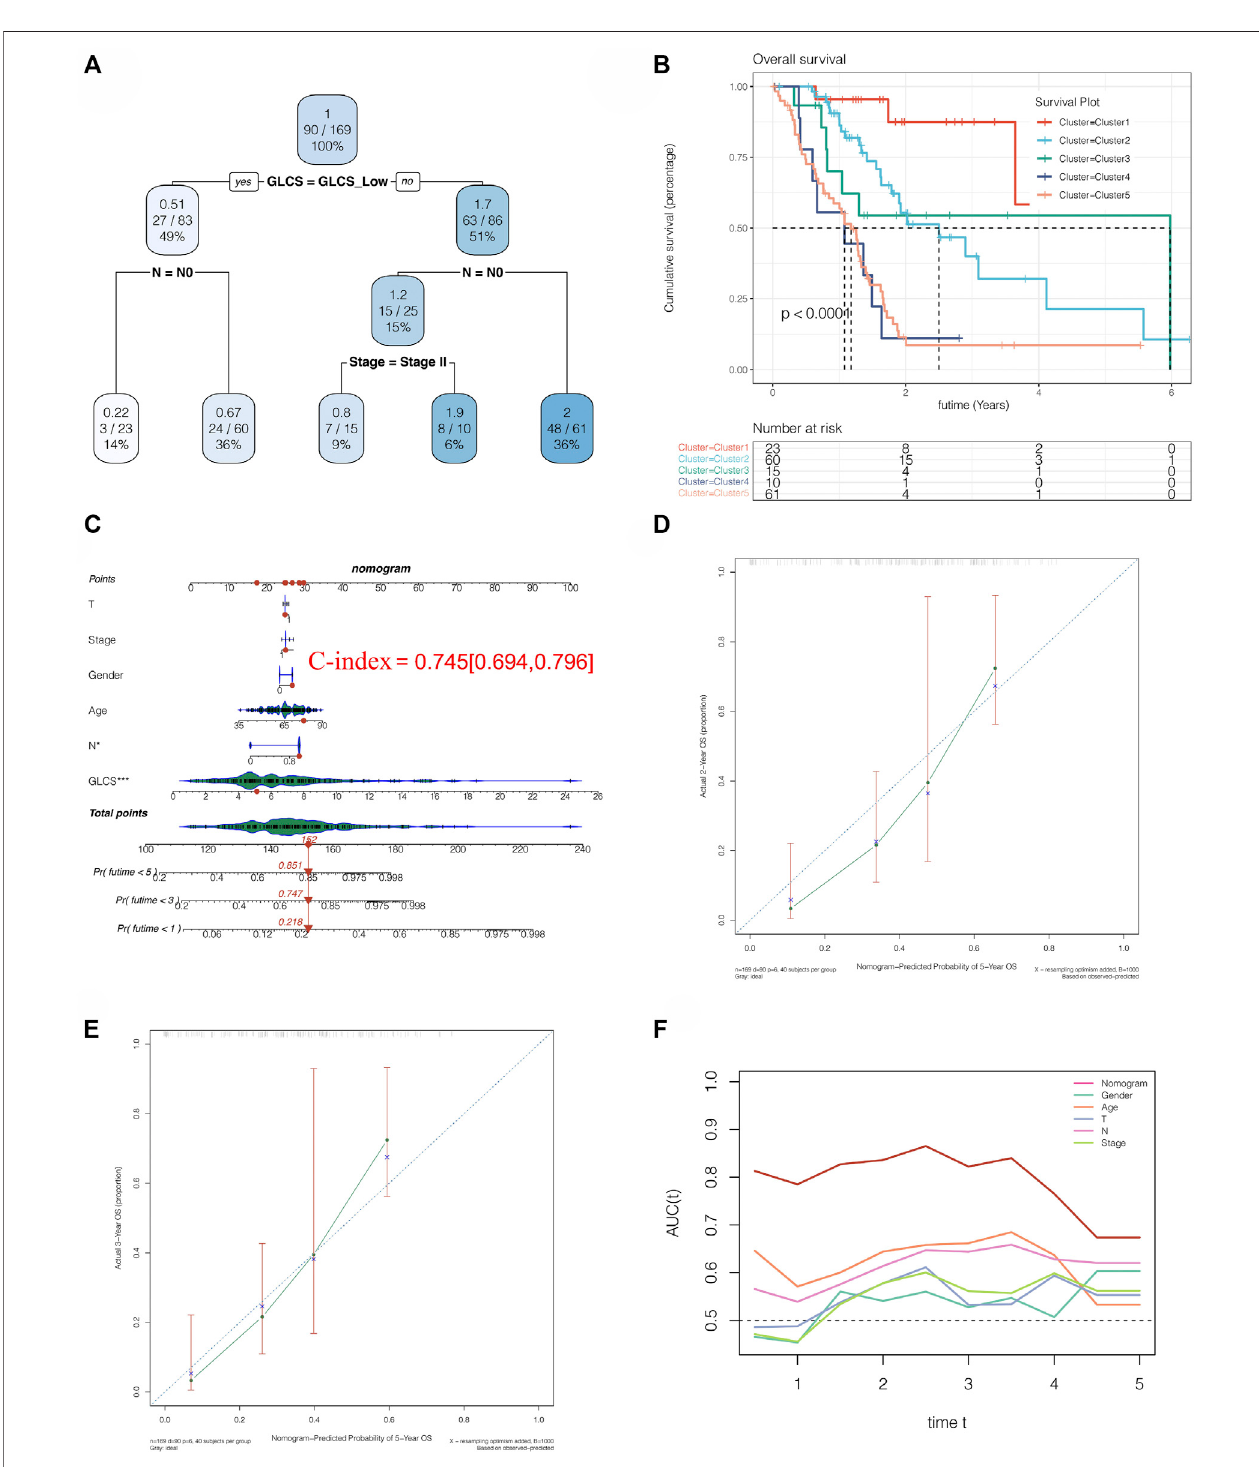
FIGURE 9 | Clinical implications of the signature. (A) Decision tree analysis could divide PC patients into fi ve risk subtypes. (B) Five risk subtypes have different prognosis, and cluster 1 has a best prognosis. (C) Nomogram analysis showed the 1-, 3-, and 5-year mortality rates of patient TCGA-S4-A8RP. (D,E) 2- and 3-year calibration curves of the nomogram. (F) AUC of the nomogram and other clinical features to evaluate the prognosis of PC.